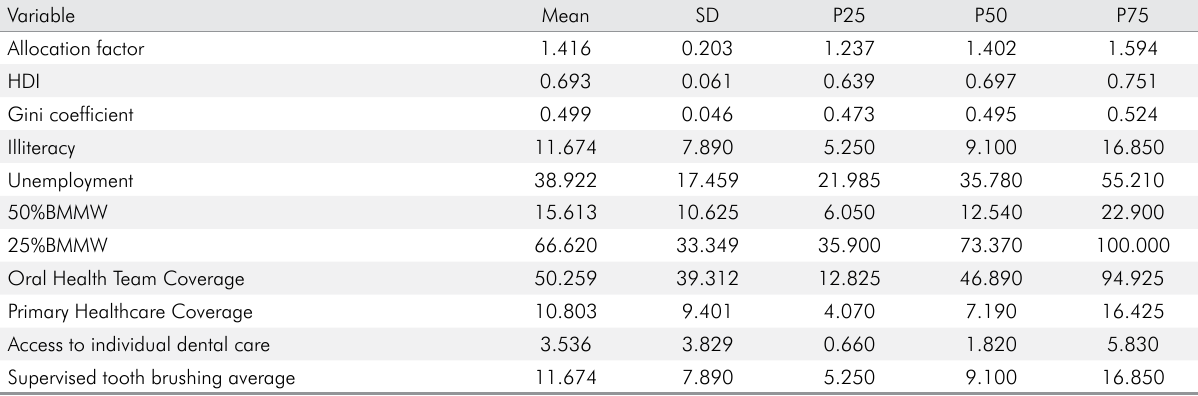
Table 5. Descriptive analysis of contextual variables. Minas Gerais. Brazil. 2012.